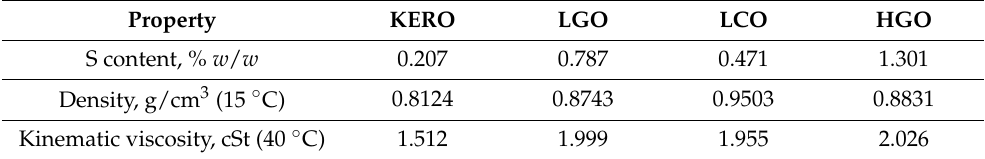
Table 2. Properties of the surrogate feeds corresponding to petroleum middle distillates. Property KERO LGO